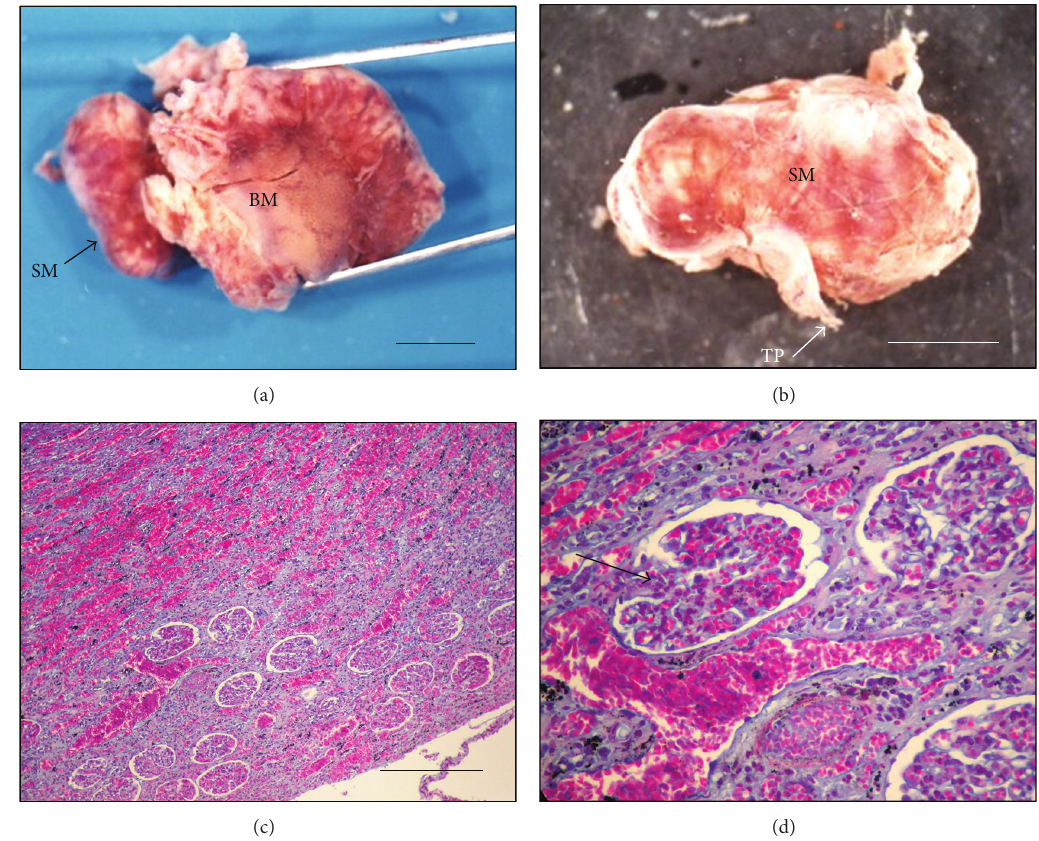
Figure 1: Macro- and microscopic views of the degu’s intraperitoneal masses. (a) External aspect of the bigger (BM) and the smaller (SM) masses. They were enveloped by a thin translucent membrane and were profusely irrigated. The arrows depict the zone of the chorionic villus (CV) (see also Figure 5) and the zone of the apparent umbilical cord (UC) (see also Figure 3(d)). A remnant of the small intestine (SI) near the bigger mass is also observed. (b) Smaller mass showing the thin process (white arrow heads) that connects to the bigger mass. (c) Photomicrograph showing the kidney-like tissue formation towards the peripheral surface of the bigger mass. (d) Higher magnification of a selected region from (c) showing three glomerulus, one of them depicting a clear vascular pole (arrow). (c and d) Trichromic Masson staining. Calibration bars (a) = 1.5 cm; (b) = 3.2 cm; (c) = 198 𝜇 m; (d) = 52 𝜇 m.